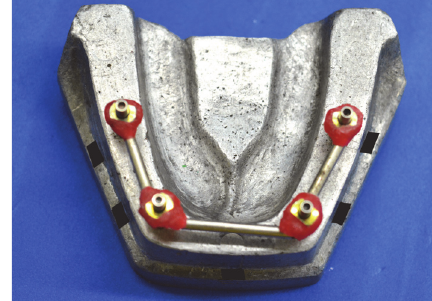
Figure 2: Metal splinted tapered impression